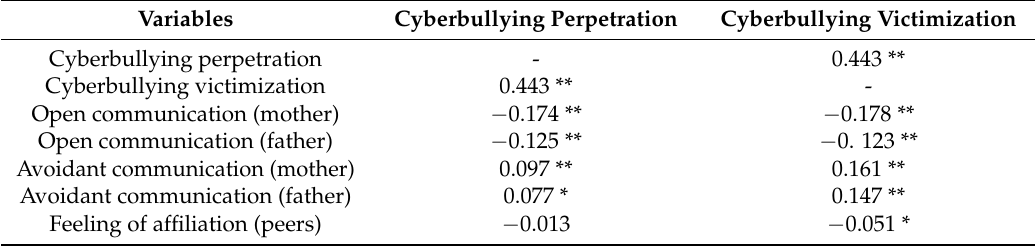
Table 1. Pearson correlations between cyberbullying (perpetration and victimization) and the study variables. Variables Cyberbullying Perpetration Cyberbullying